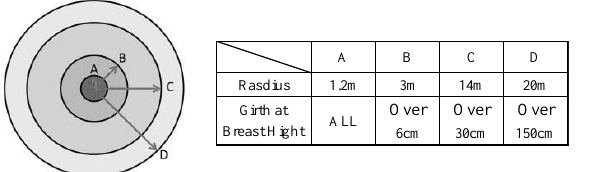
Figure 2. Shape and size of plots